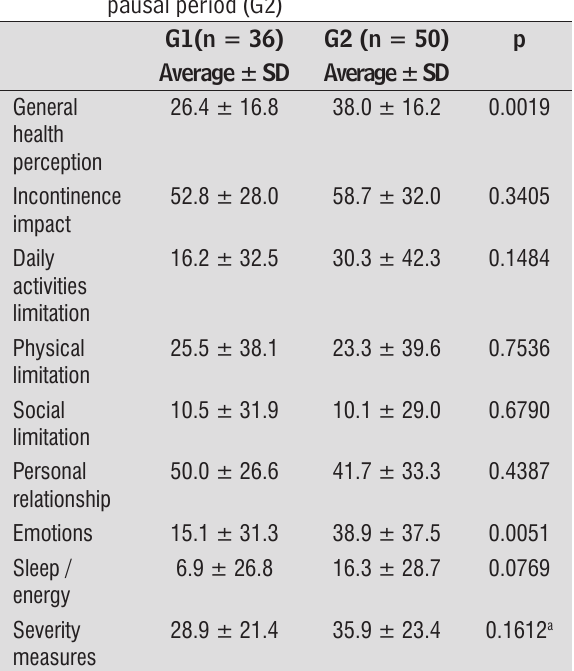
Table 4 - Scores of quality of life, according to King’s Health Questionnaire (KHQ) domains in women